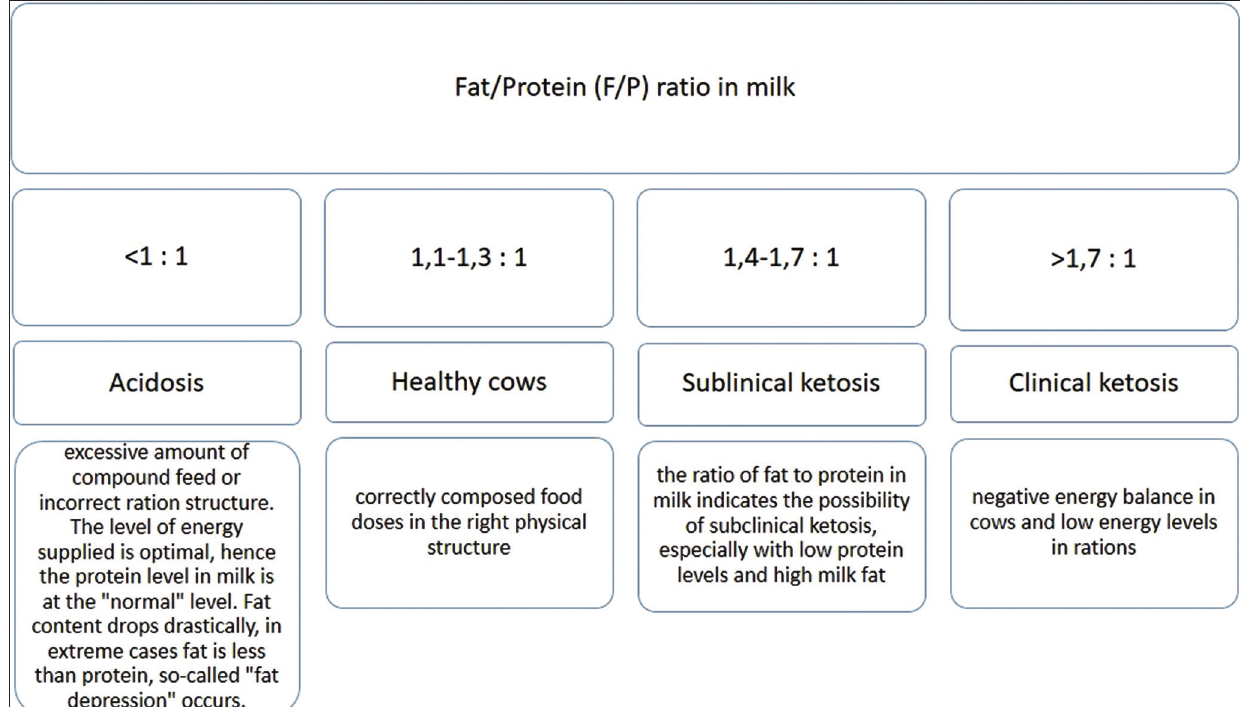
Figure 6: Interpretation of the rationality of cow nutrition based on the fat-protein ratio in